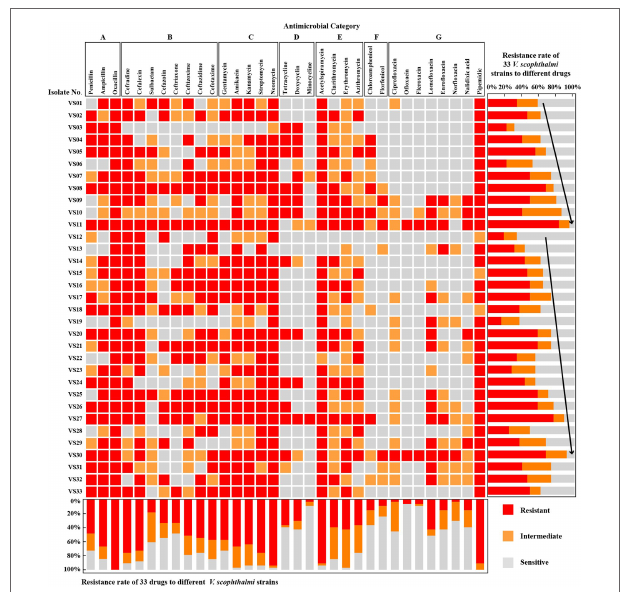
FIGURE 1 | Antimicrobial susceptibility tests of 33 V. scophthalmi isolates to different kinds of